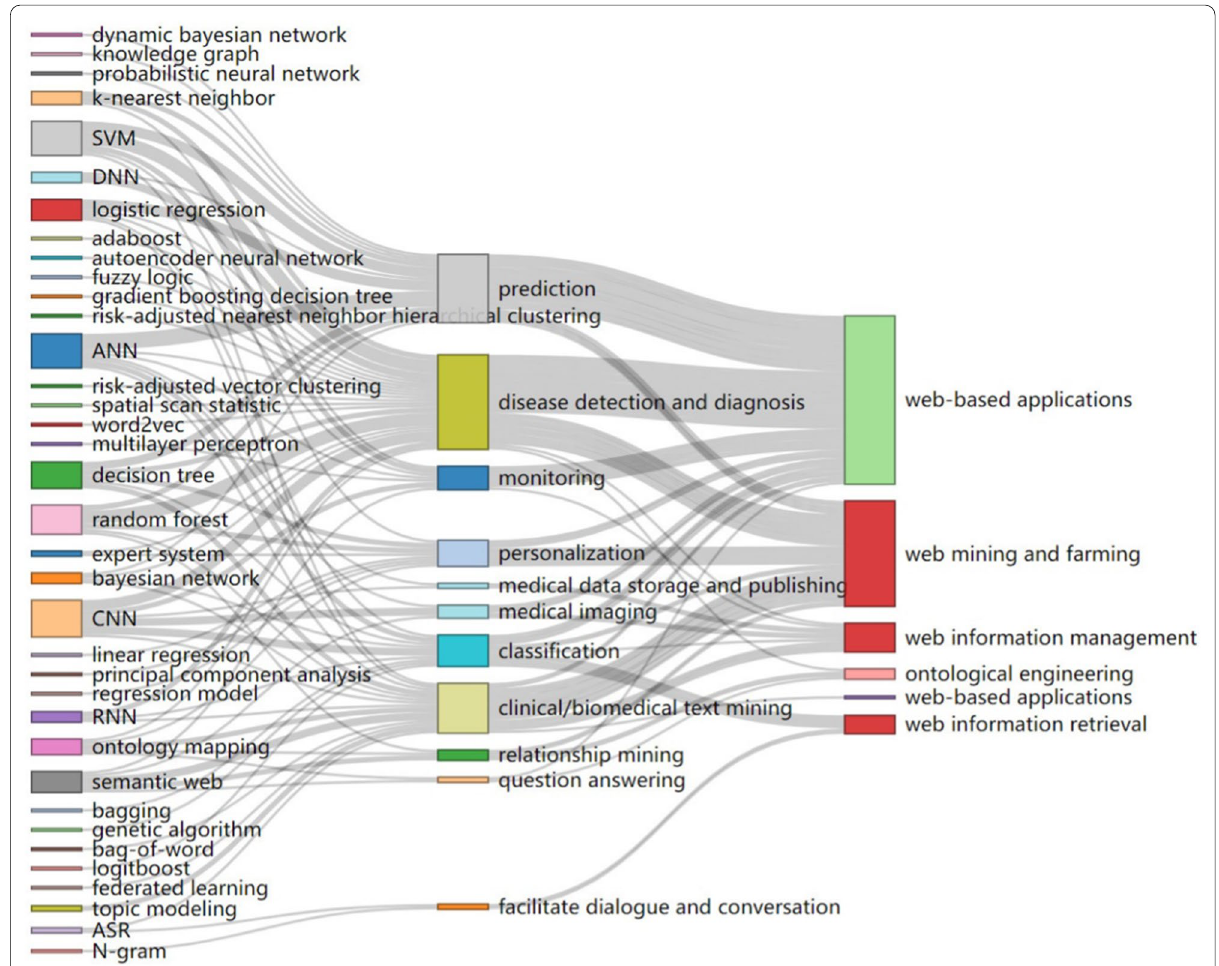
Fig. 15 Relationship between AI, tasks, and Web intelligence scopes (downloading interactive graphics via https:// drive. google. com/ file/d/ 1kkA0 oo8VZ 4DhyI iFliW 7S59p UKjW_ hRI/ view? usp shari =